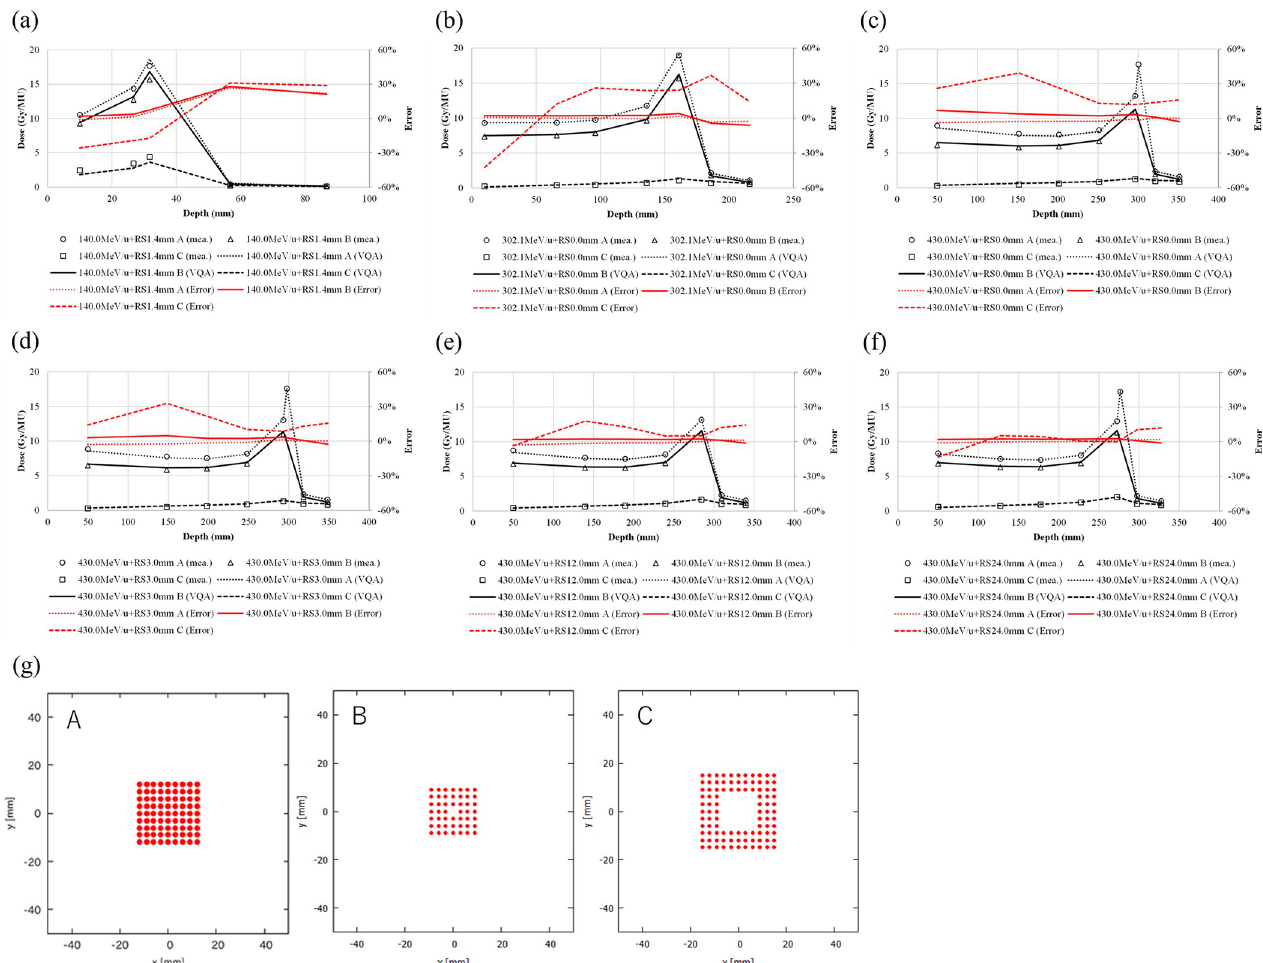
Fig 6. Doses measured in the irradiation of frame patterns A–C for a pencil beam. Point doses for a pencil beam with an energy of 430.0 MeV/u at energies (a– c) 140.0, 302.1, and 430.0 MeV/u, (a–c, respectively), and with an RS of 3.0, 12.0, and 24.0 mm (d–f, respectively). The measured absolute doses are shown for patterns A (circles), B (triangles), and C (squares), whereas the TPS-calculated absolute doses are shown for patterns A (dotted lines), B (solid lines), and C (dashed lines). The errors in the calculation relative to the measurement are shown for patterns A (red dotted lines), B (red solid lines), and C (red dashed lines). (g) Three selected frame